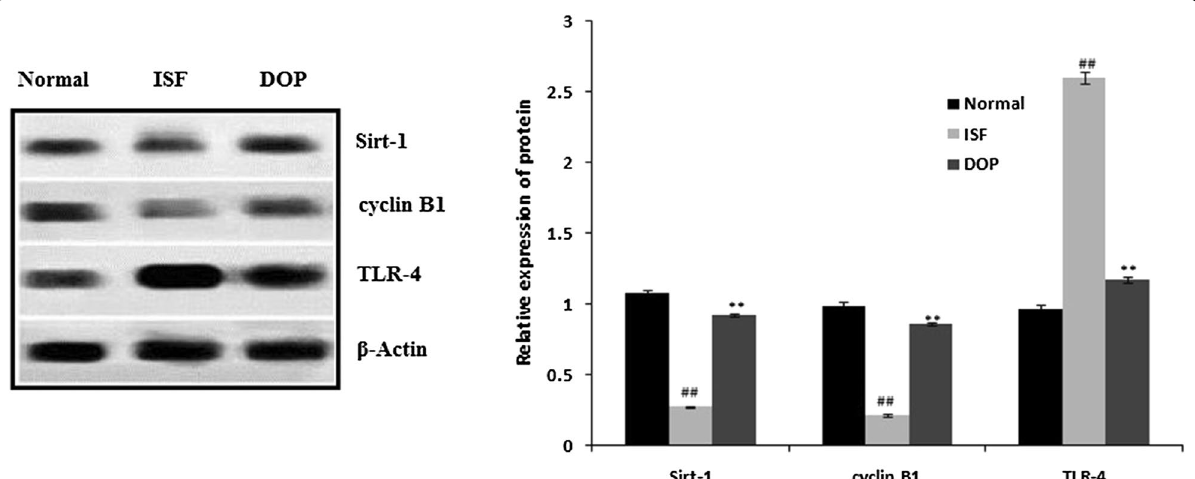
Fig. 6 Desoxyrhapontigenin ameliorates the protein expression of TLR-4, cyclin B1, and Sirt-1 in the brain tissues of rats with anaesthesia-induced neuronal injury. Mean